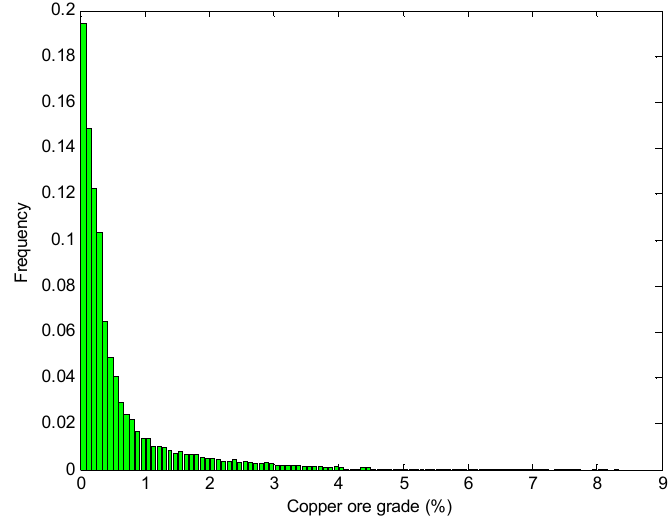
Figure 7. Frequency distribution histogram of the copper ore grade.